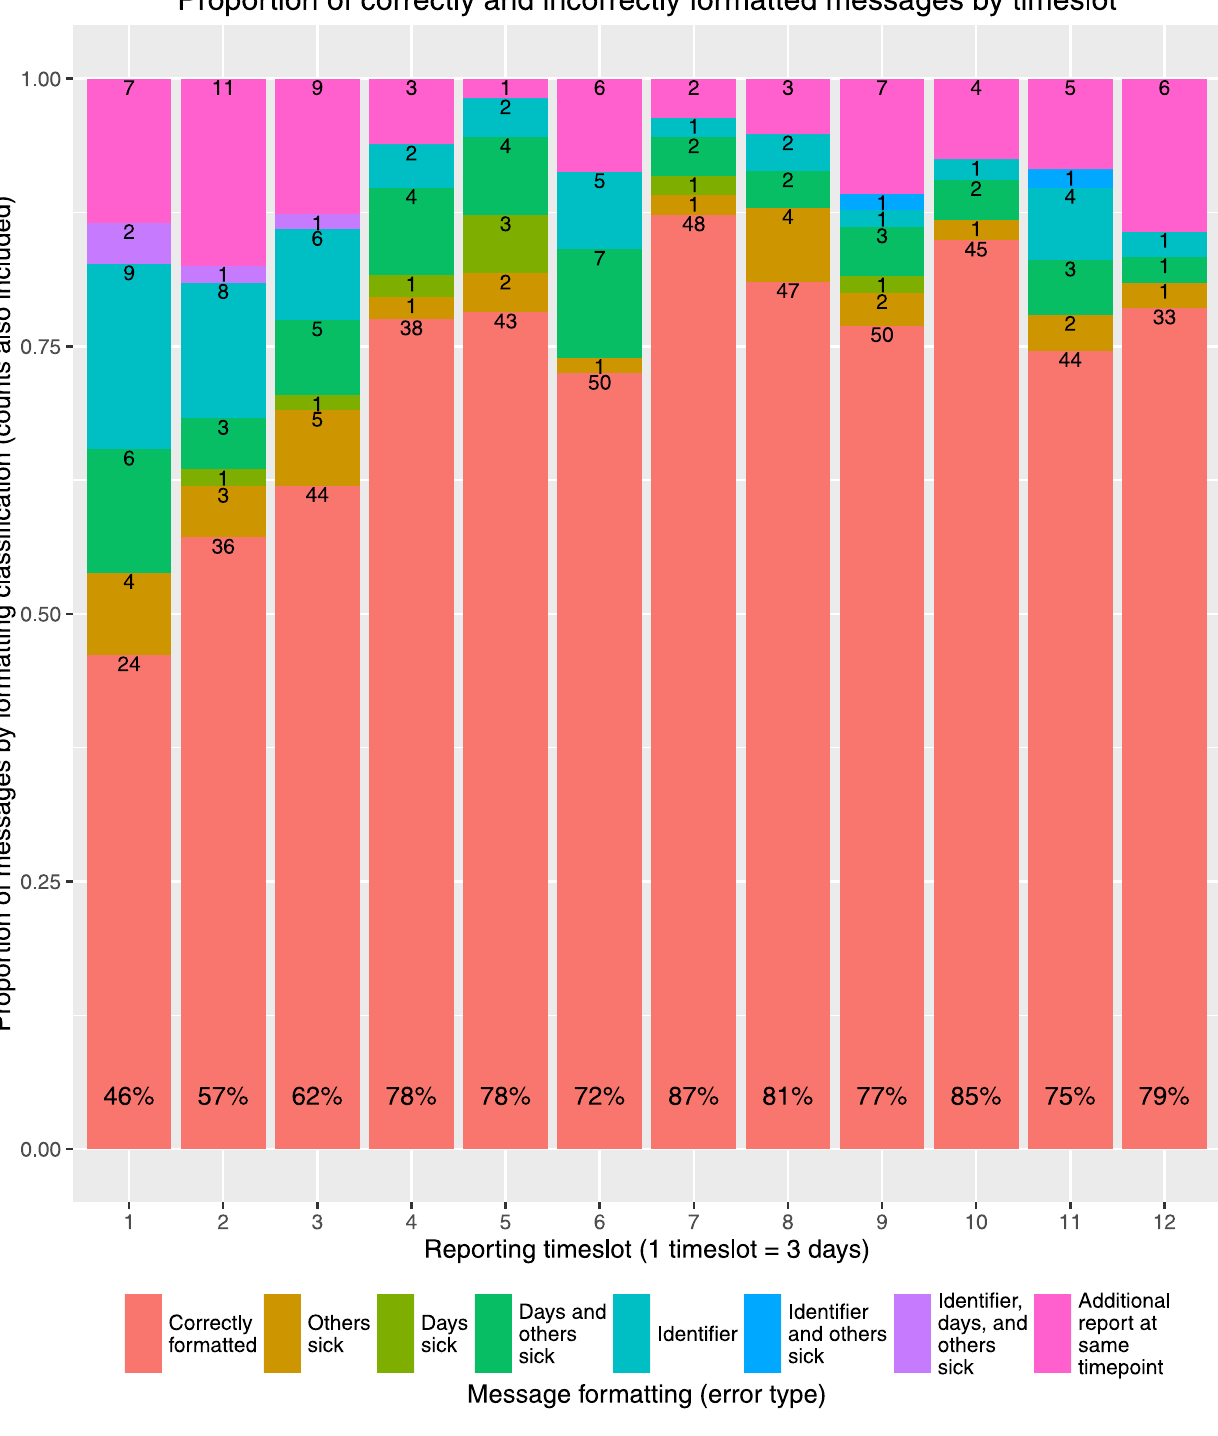
PLOS ONE | DOI:10.1371/journal.pone.0155971 June 9,